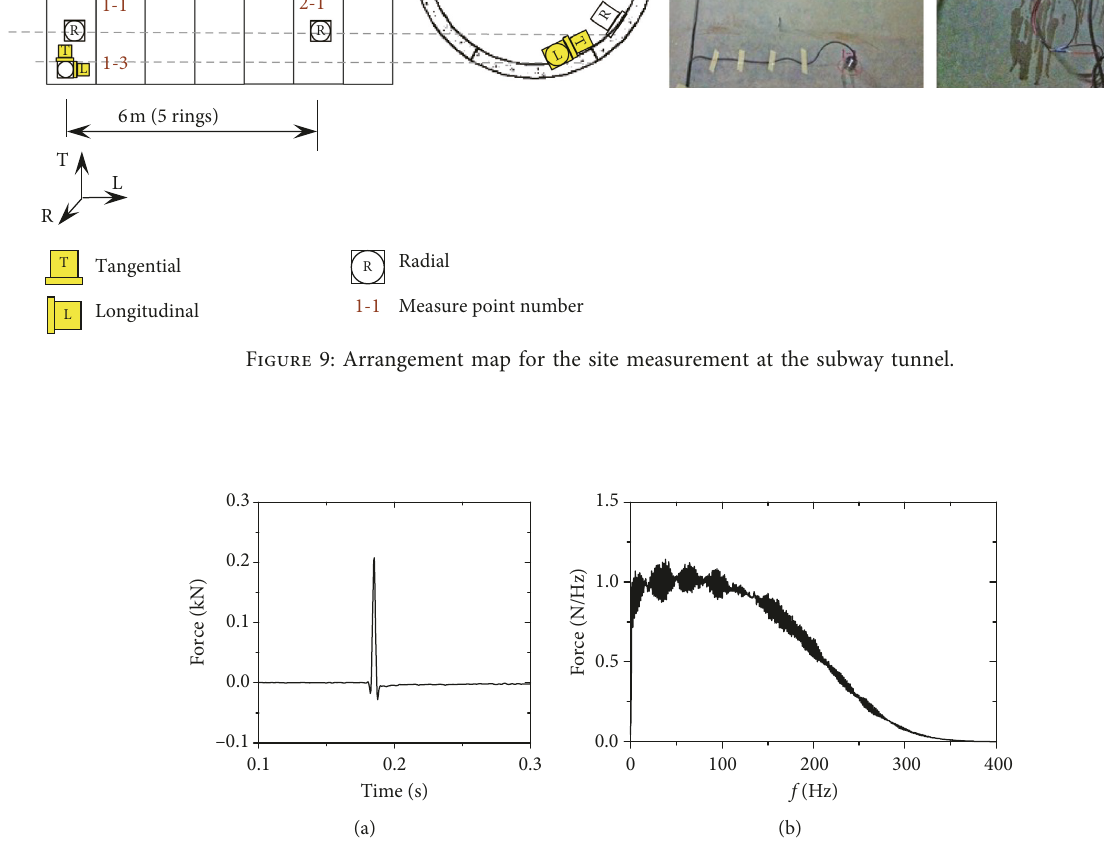
Figure 10: The hammer impulse load applied in the subway tunnel: (a) time spectrum; (b) frequency spectrum.